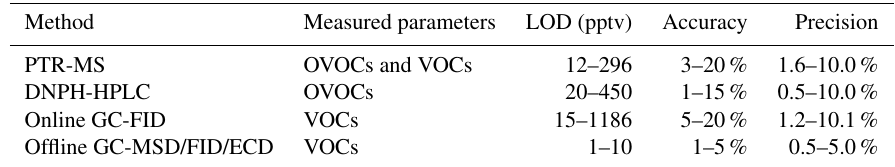
Table 2. Summary of detection limit, accuracy, and precision of different techniques used in this